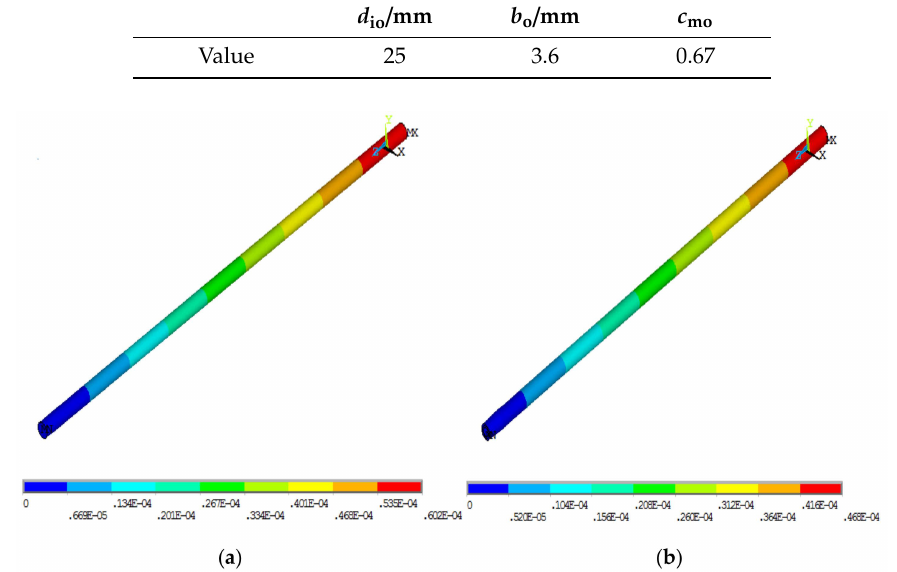
Figure 15. Simulation results. ( a ) Ordinary ball screw; ( b ) Optimized improved ball screw.